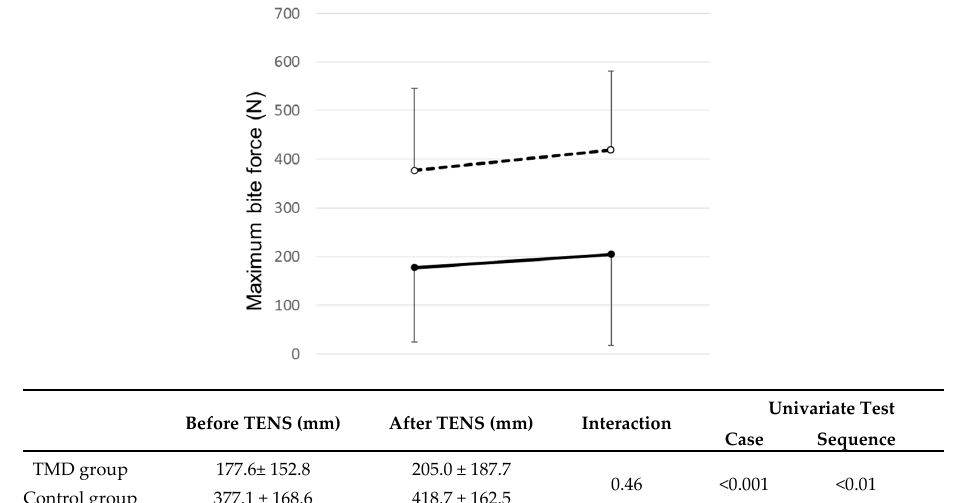
Figure 3. Maximum mouth opening before and after transcutaneous electrical nerve stimulation (TENS) application. Data are the mean ± standard deviation. The solid line indicates the temporomandibular disorder (TMD) group, and the dotted line indicates the control group. Case indicates the comparison between TMD and control groups, whereas sequence means the comparison between before and after treatment. There was no significant difference in maximum mouth opening between the two groups (General linear model analysis). J. Clin. Med. 2020 , 9 , 3330